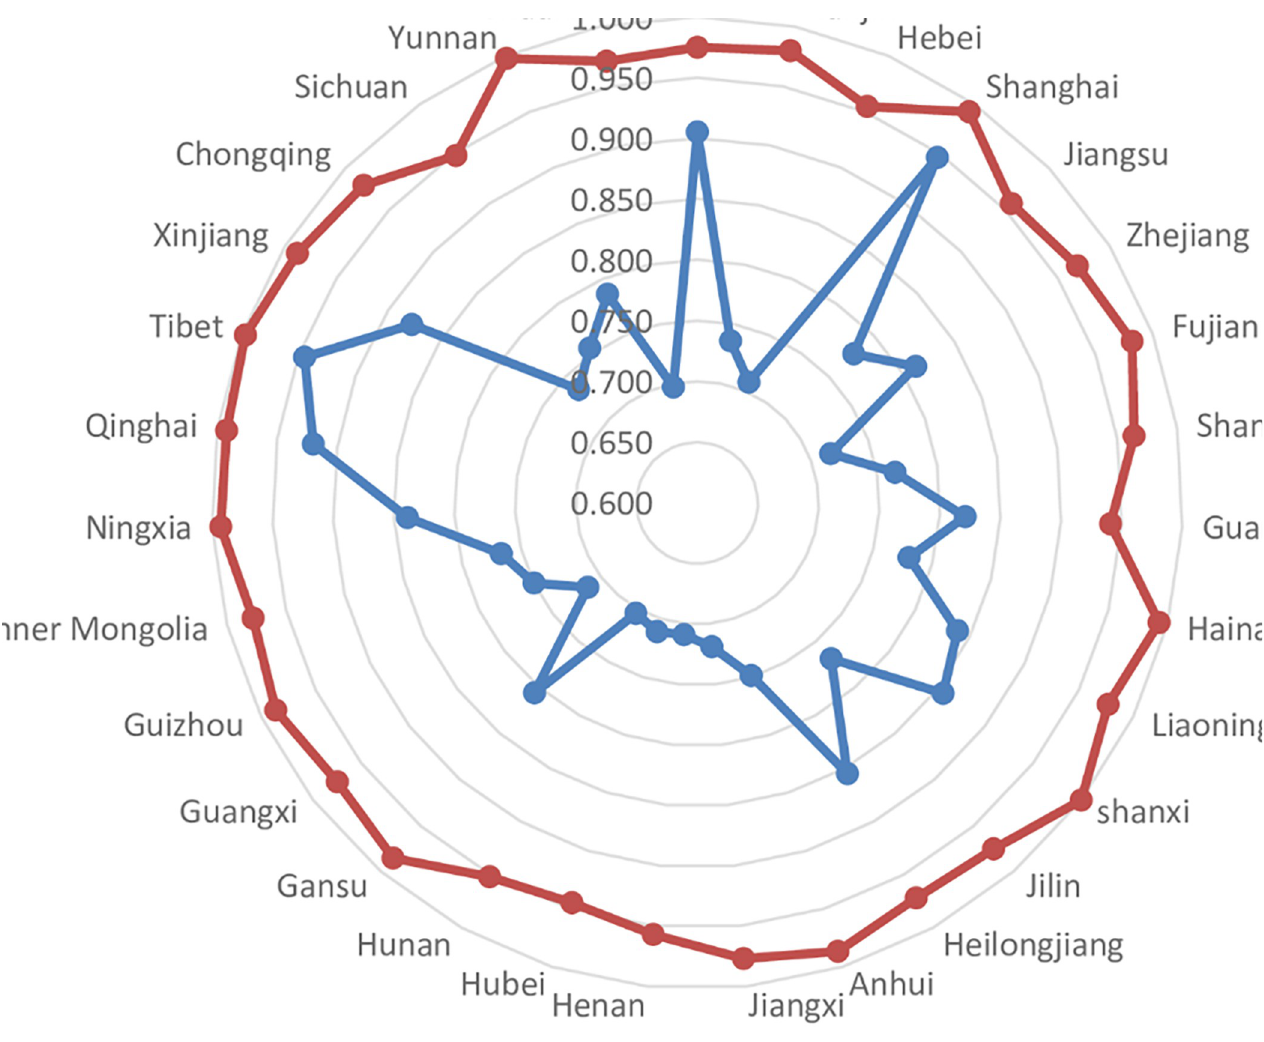
Fig 2. PTE radar diagram of Stage 1 and Stage